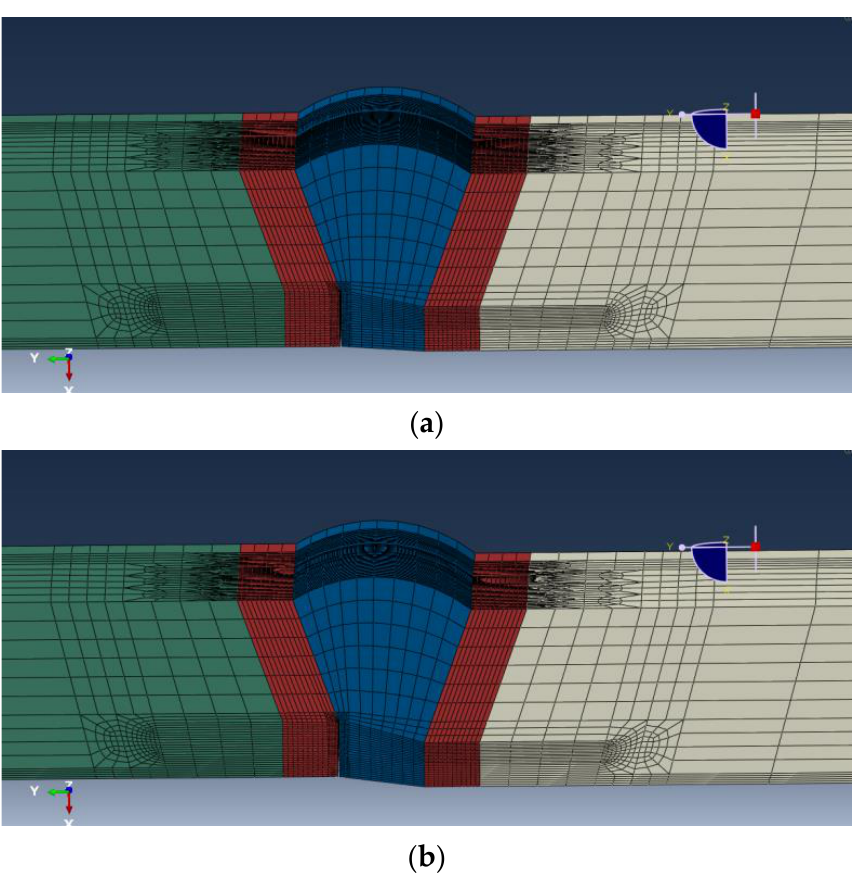
Figure 2. Weld profile modeled in FEA for 12.8 mm + 15.3 mm wall thickness (WT). ( a ) 0.8 mm